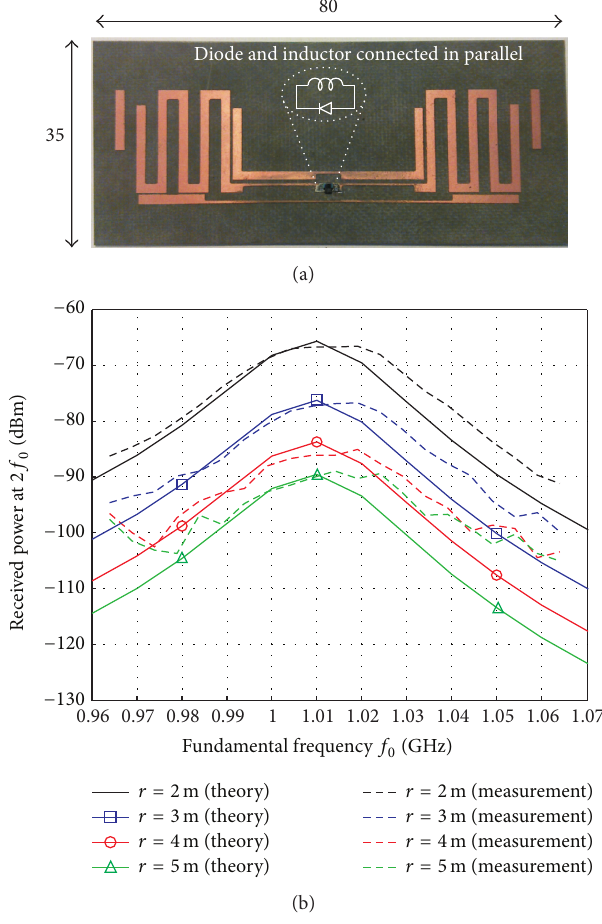
Figure 3: (a) Example transponder antenna and (b) obtained the- oretical and measured response at the second harmonic frequency 2𝑓 0 , modified from